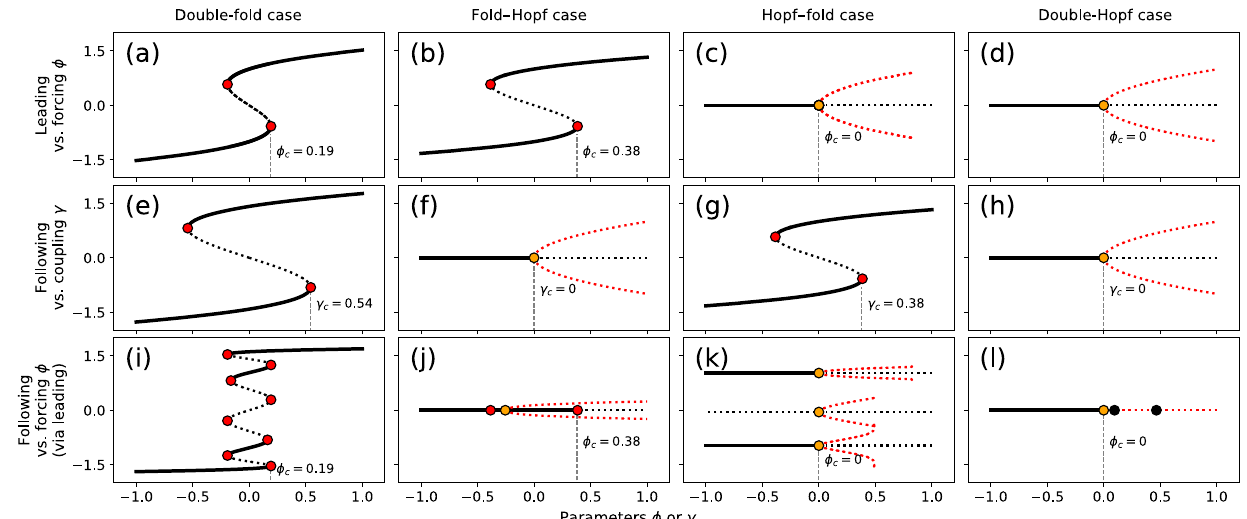
Figure 1. Stable (solid), unstable (black dotted) and oscillatory (amplitude red dotted) regimes of various cascading tipping types (as defined on top of the figure). Red, orange and black dots indicate fold, Hopf and torus bifurcations, respectively. Leading system versus forcing φ (a–d) . Following system versus coupling γ (e–h) . Following system versus forcing φ (via leading) (i–l) . Critical values of (coming from lower branch) leading tipping (a–d) , following tipping (e–h) and the combined cascading tipping event (i–l) are marked by the grey vertical dashed line.